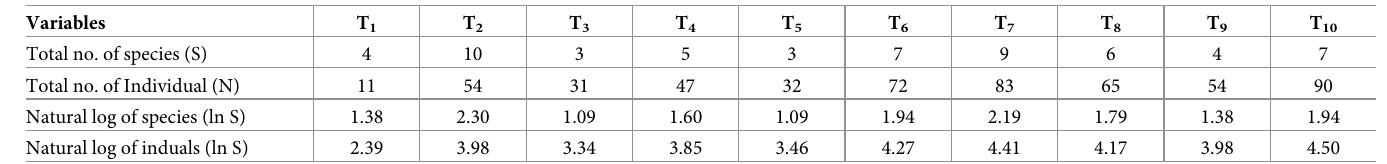
Ten transects of 0.1 ha were delineated in foorest area and selected 16 tree species and 539 individuals in all transect.A total of 16 tree species belonging to 13 genera and 11 families have been recorded. In this way 539 individuals were recorded in 10 transects 0.1 ha. Other species were few in numbers and occurred as associate species forming mixed tree species. Transect- wise species record has been presented in Table 1. Table 1. Transect-wise species recorded in